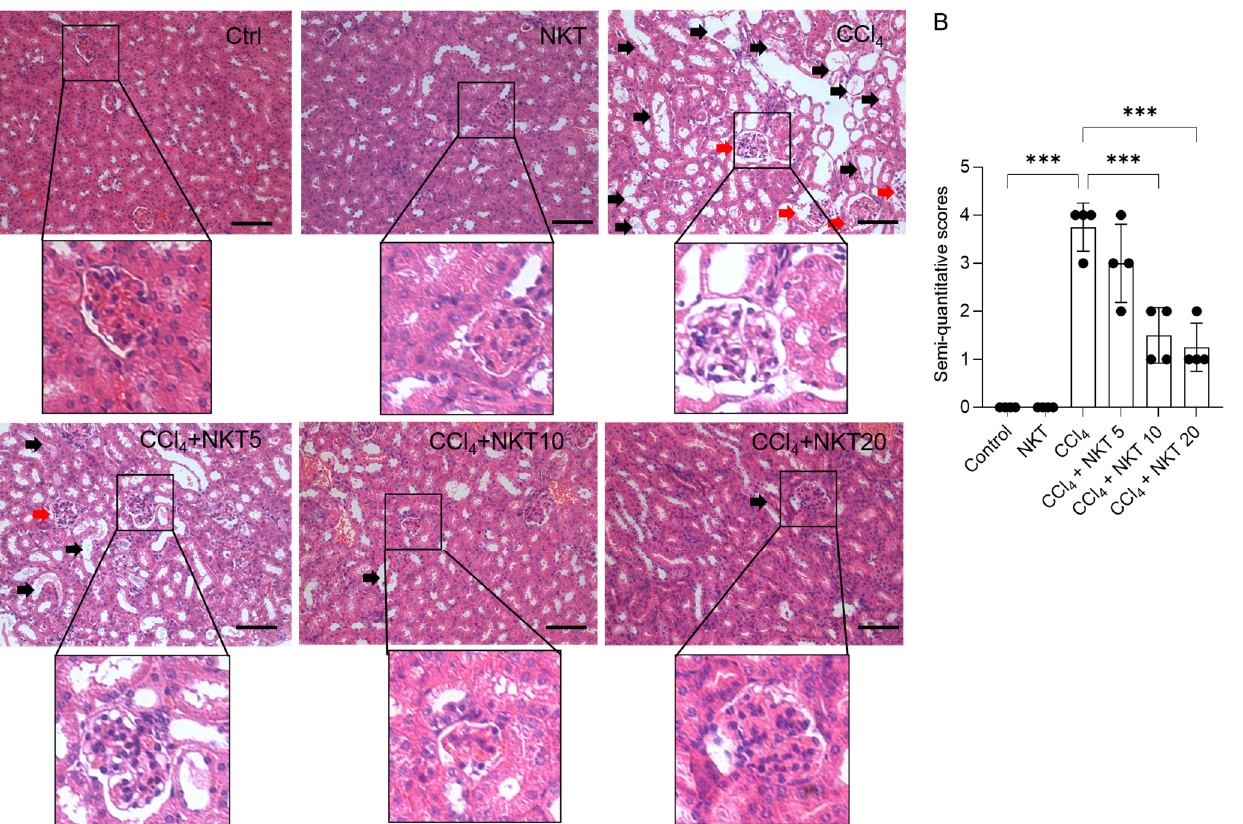
Figure 4. NKT pre-treatment improves CCl 4 exposure-caused renal damage in mice. Mice were pretreated with NKT at 5, 10, and 20 mg/kg/day for seven successive days, then were treated with 0.3% CCl 4 . After 24 h, the histopathological changes were assessed. ( A ), the representative images were shown and a magnification of the glomerulus in each image were performed. ( B ), the result of semi-quantitative score. Data are presented as mean ± S.D. ( n = 4 in each group). The black arrow indicated marked tubular degeneration, necrosis, tubular dilation, and cast formation. The red arrow indicated marked congestion and focal hemorrhage in glomerulus. *** p < 0.001. Bar = 50 μ m.